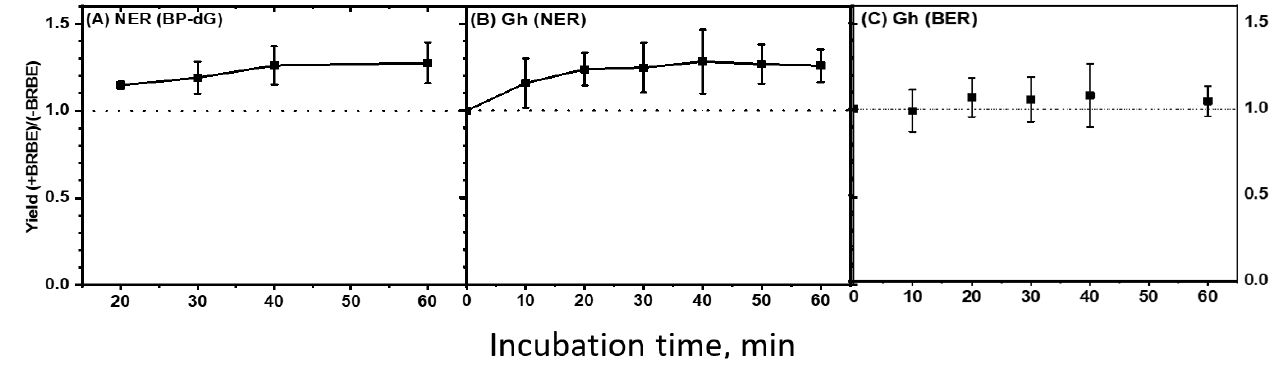
Figure 6. Time dependence of the ratios of NER product yields, [Y(+BRBE)/Y( − BRBE)] as a function of incubation time. ( A ). NER, BP-dG adduct. Each time point represents the average and standard deviations of 28 data points (see the text). The average value of all four time points shown is [Y(+BRBE)/Y( − BRBE]BP(NER) = 1.24 ± 0.09 (two-tailed t -test, p -value 0.05. ( B ). Gh lesion (NER). Time dependence of the ratios of NER product yields, [Y(+BRBE)/Y( − BRBE)], as a function of incubation time. Each time point represents the average of 32 data points, yielding an overall average value of the five time points shown [Y(+BRBE)/Y( − BRBE)]Gh(NER) = 1.24 ± 0.09 (two- tailed t -test, p -value 0.05. ( C ). Gh lesion (BER). Time dependence of the ratios of BER product yields, [Y(+BRBE)/Y( − BRBE)]Gh(BER) as a function of incubation time. Average value calculated as in panel B: [Y(+BRBE)/Y( − BRBE)]Gh(BER) = 1.06 ± 0.01 ( p -value <